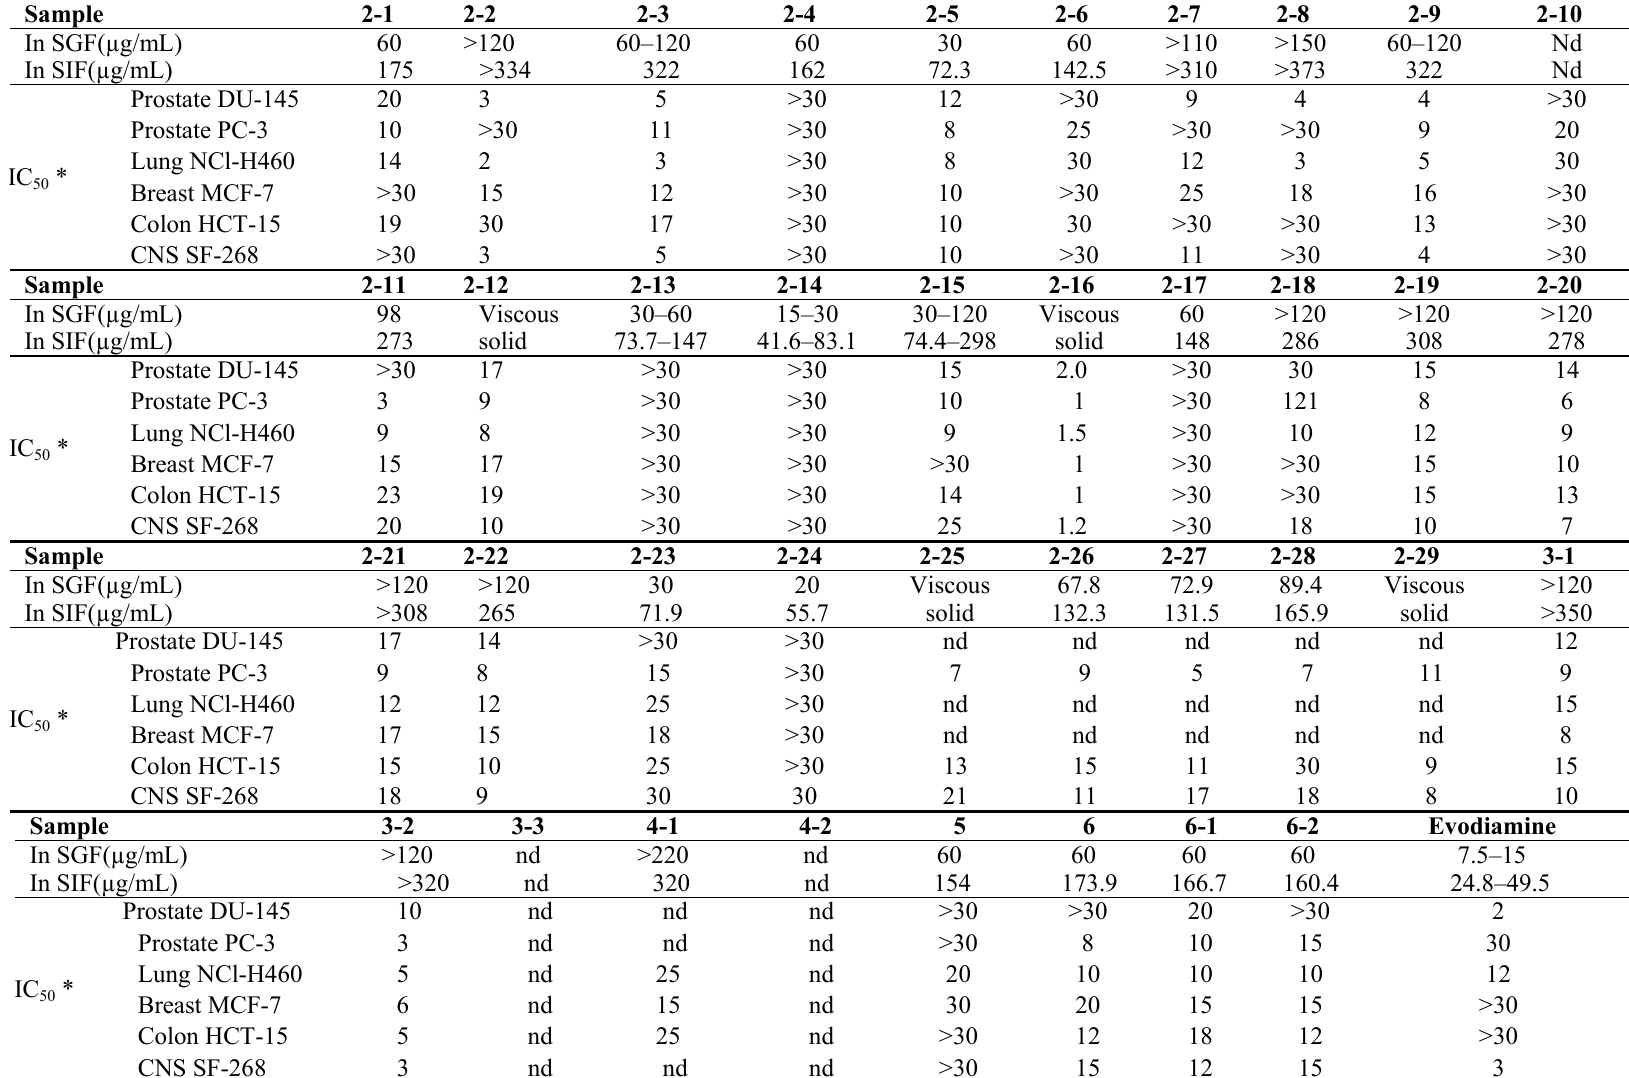
Table 1. Solubilities and cytotoxicity of N13-substituted evodiamine